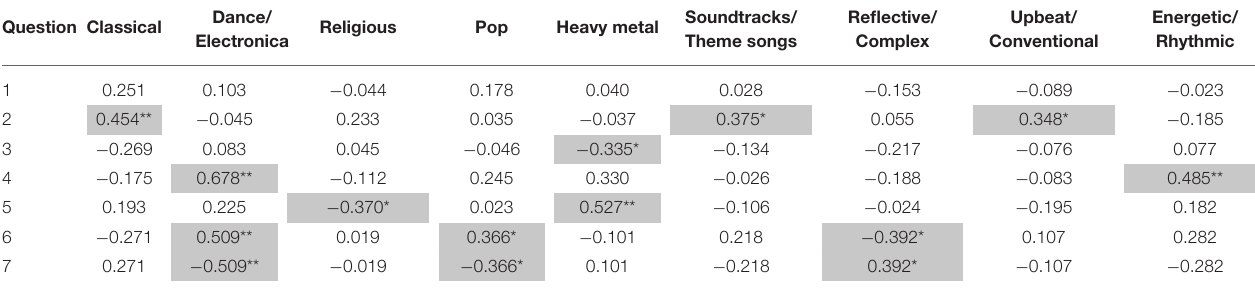
TABLE 6 | Coefficients of Spearman’s rank correlations between questions about headphones and speakers and STOMP items ( N = 35). Question